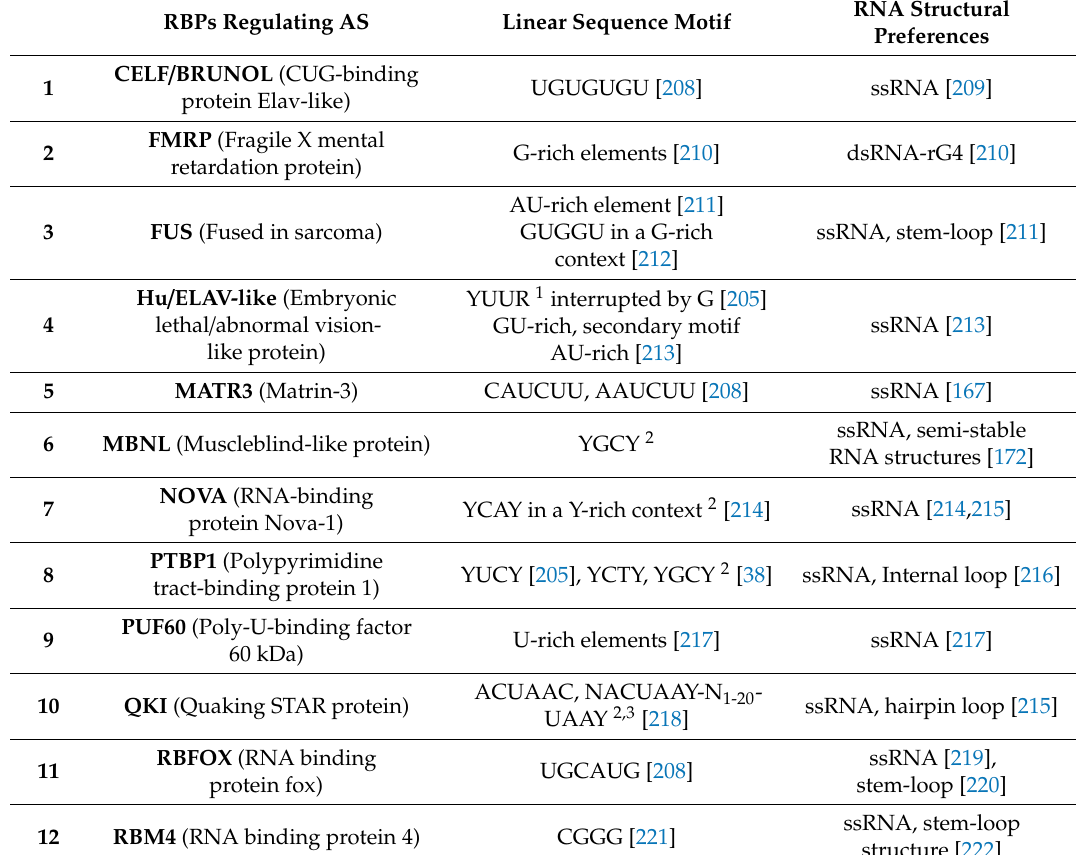
Table 1. Preferences of selected RBPs towards RNA linear consensus motifs and RNA structural